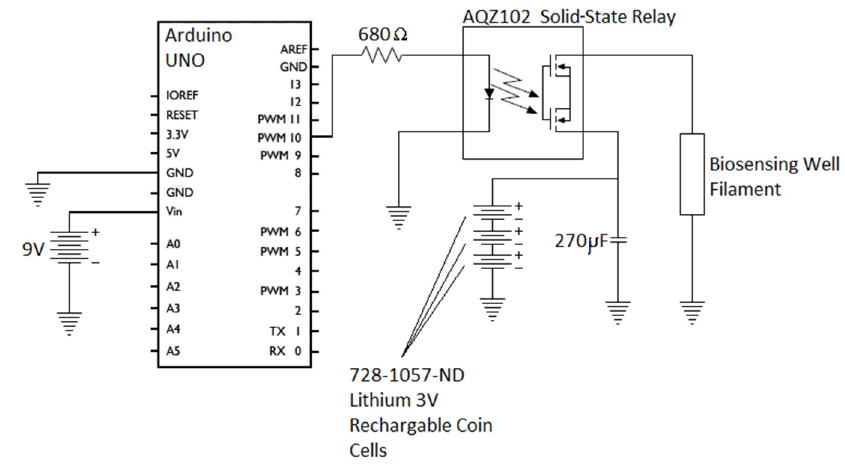
Figure 3. Pulse current circuit.